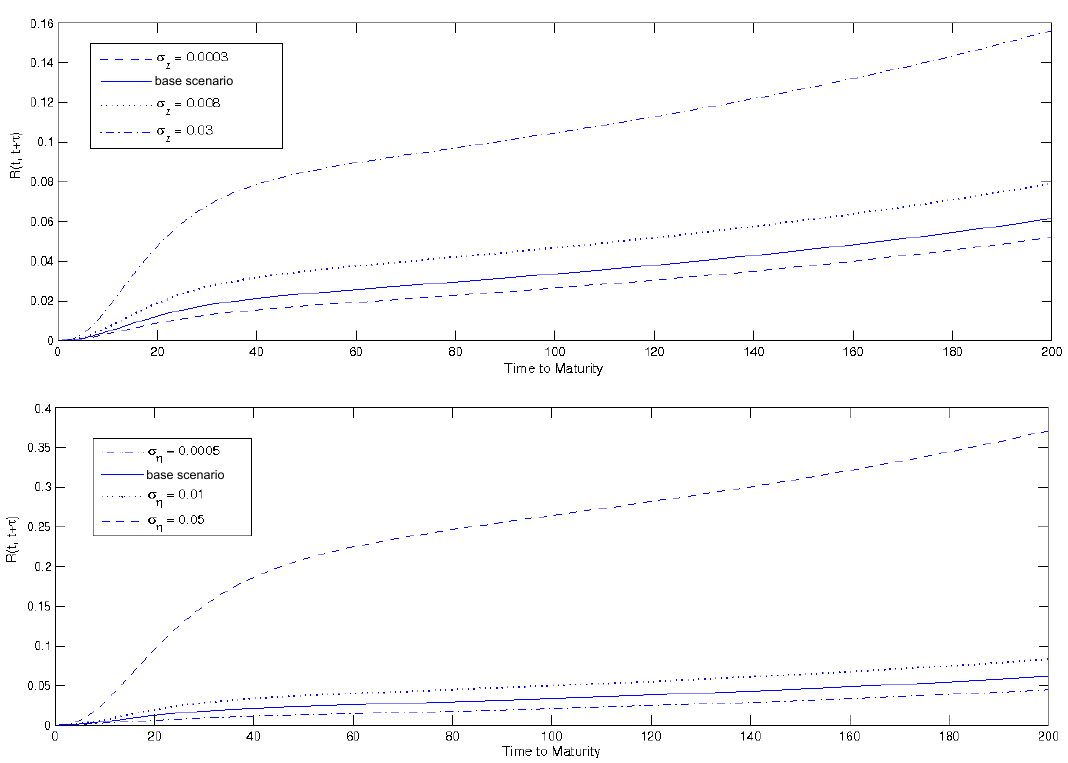
Figure 15. Spot yield to varying parameters σ z and σ η